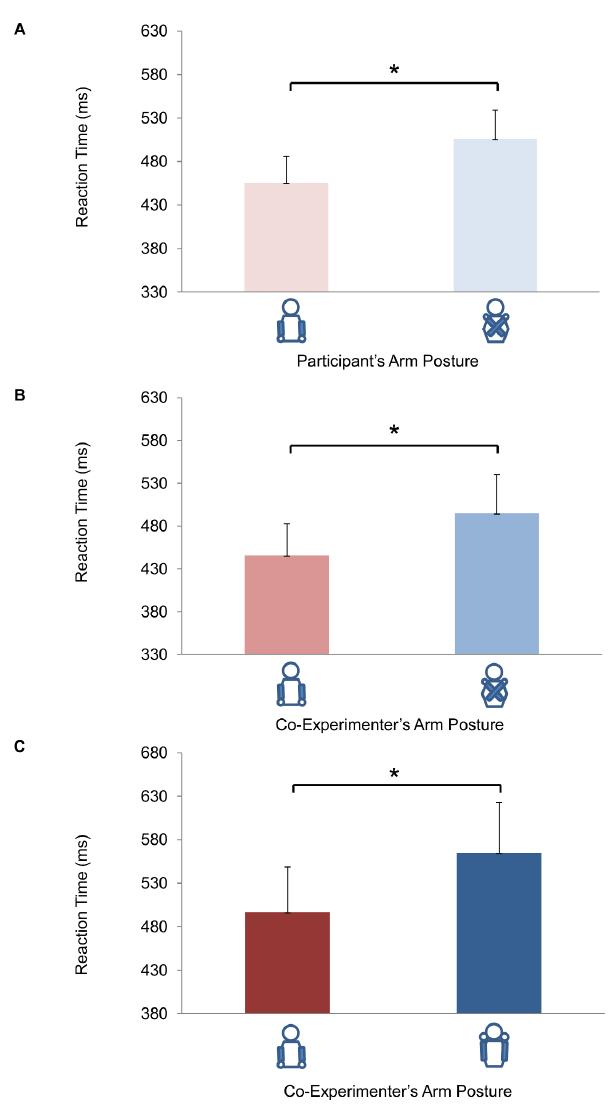
Figure 5. Effects of experimental manipulation on front/back judgments in the three experiments. Main effect of Participant Arm Posture in Experiment 1 (Panel A) and main effect of Co-experimenter Arm Posture in Experiments 2 and 3 (Panel B and C, respectively) on Reaction Times. Bars represent standard errors of the means. Asterisks indicate significance for the main contrasts of interest ( p , 05). Please note that all these main effects refer to the very same hand-object